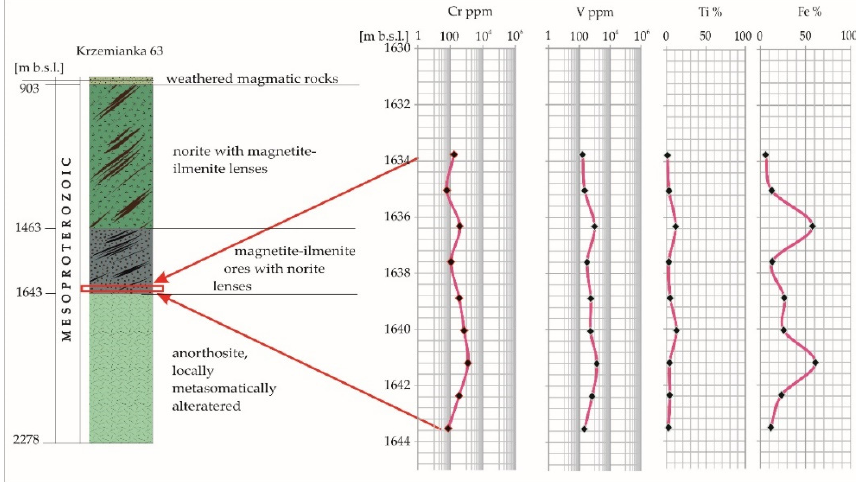
Figure 5. Schematic geological profile of the Krzemianka 63 drill hole, together with the results of analyses carried out with a portable XRF spectrometer to assess the content of Cr, V, Ti, and Fe (as a percentage) in the selected ore interval.